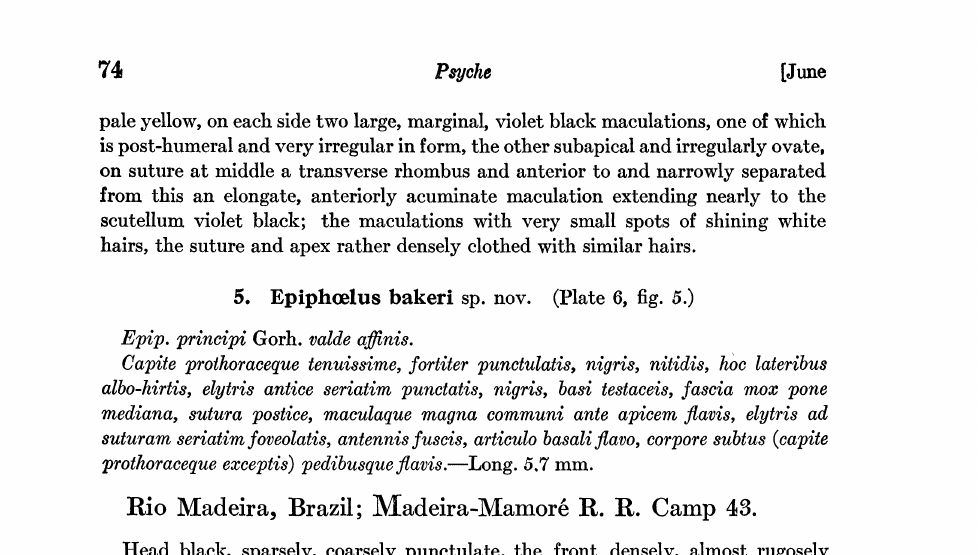
Head black, sparsely, coarsely punctulate, the front densely, almost rugosely punctate. Antennae fuscous, basal joint yellowish white. Thorax black, coarsely but very sparsely punctate; sides conspicuously clothed with long, dense, white hairs. Elytra black, basal fourth (except extreme flanks) testaceous; a submedian fascia (broad at the suture, narrow at the flanks), suture posteriorly and a large, common, ante-apical maculation, yellow; surface rather coarsely seriately punctate from base to fascia, behind which the puncturing is gradually finer, the outer rows longest and becoming obsolete at apical fourth; bordering suture each side a series of distinct, sparsely placed fovee, these extending from the base to the apex; pube- scence clothing the suture and the pale portions long, dense and